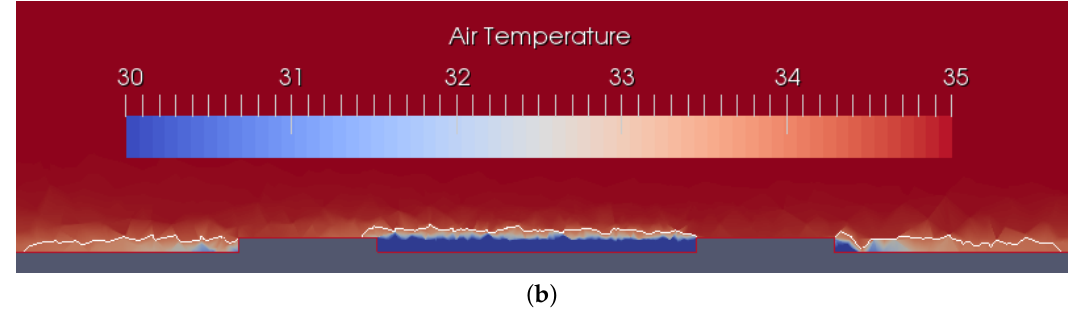
Figure 10. Vertical slice of the air temperature field for a high building density district. ( a ) UF 7: buildings are 4 m high; ( b ) UF 3: buildings are 10 m high—the white line is the 34 °C isotherm. The air temperature field for UF 1 and UF 6 (buildings 10 m and 17 m high, respectively, in a low-density district—many streets) is presented Figure 11. For the UF 1, the cool air did not pass over the buildings; it remained channeled in the streets. It is obvious that in this case building height increases did not affect the spreading of cool air.